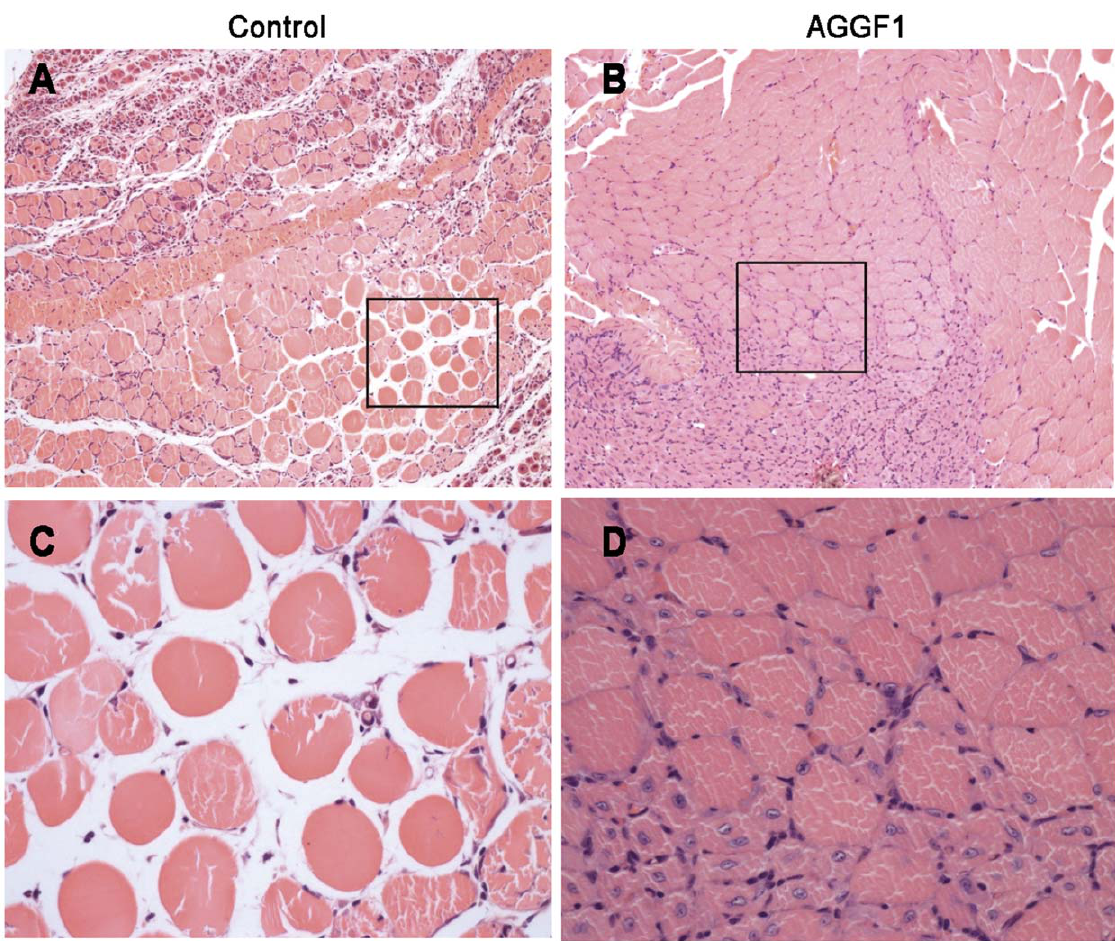
Figure 4. Histological examinations of muscle tissues. A ) Ischemic hindlimb muscle sections from ischemic mice showed severe necrosis 7 days after injection of empty vector DNA. B ) Ischemic mice injected with AGGF1 plasmid DNA showed much less necrosis and retained intact muscle 7 days after injection of DNA. C ) Enlarged image for a section from A ). D ) Enlarged image for a section from B ).